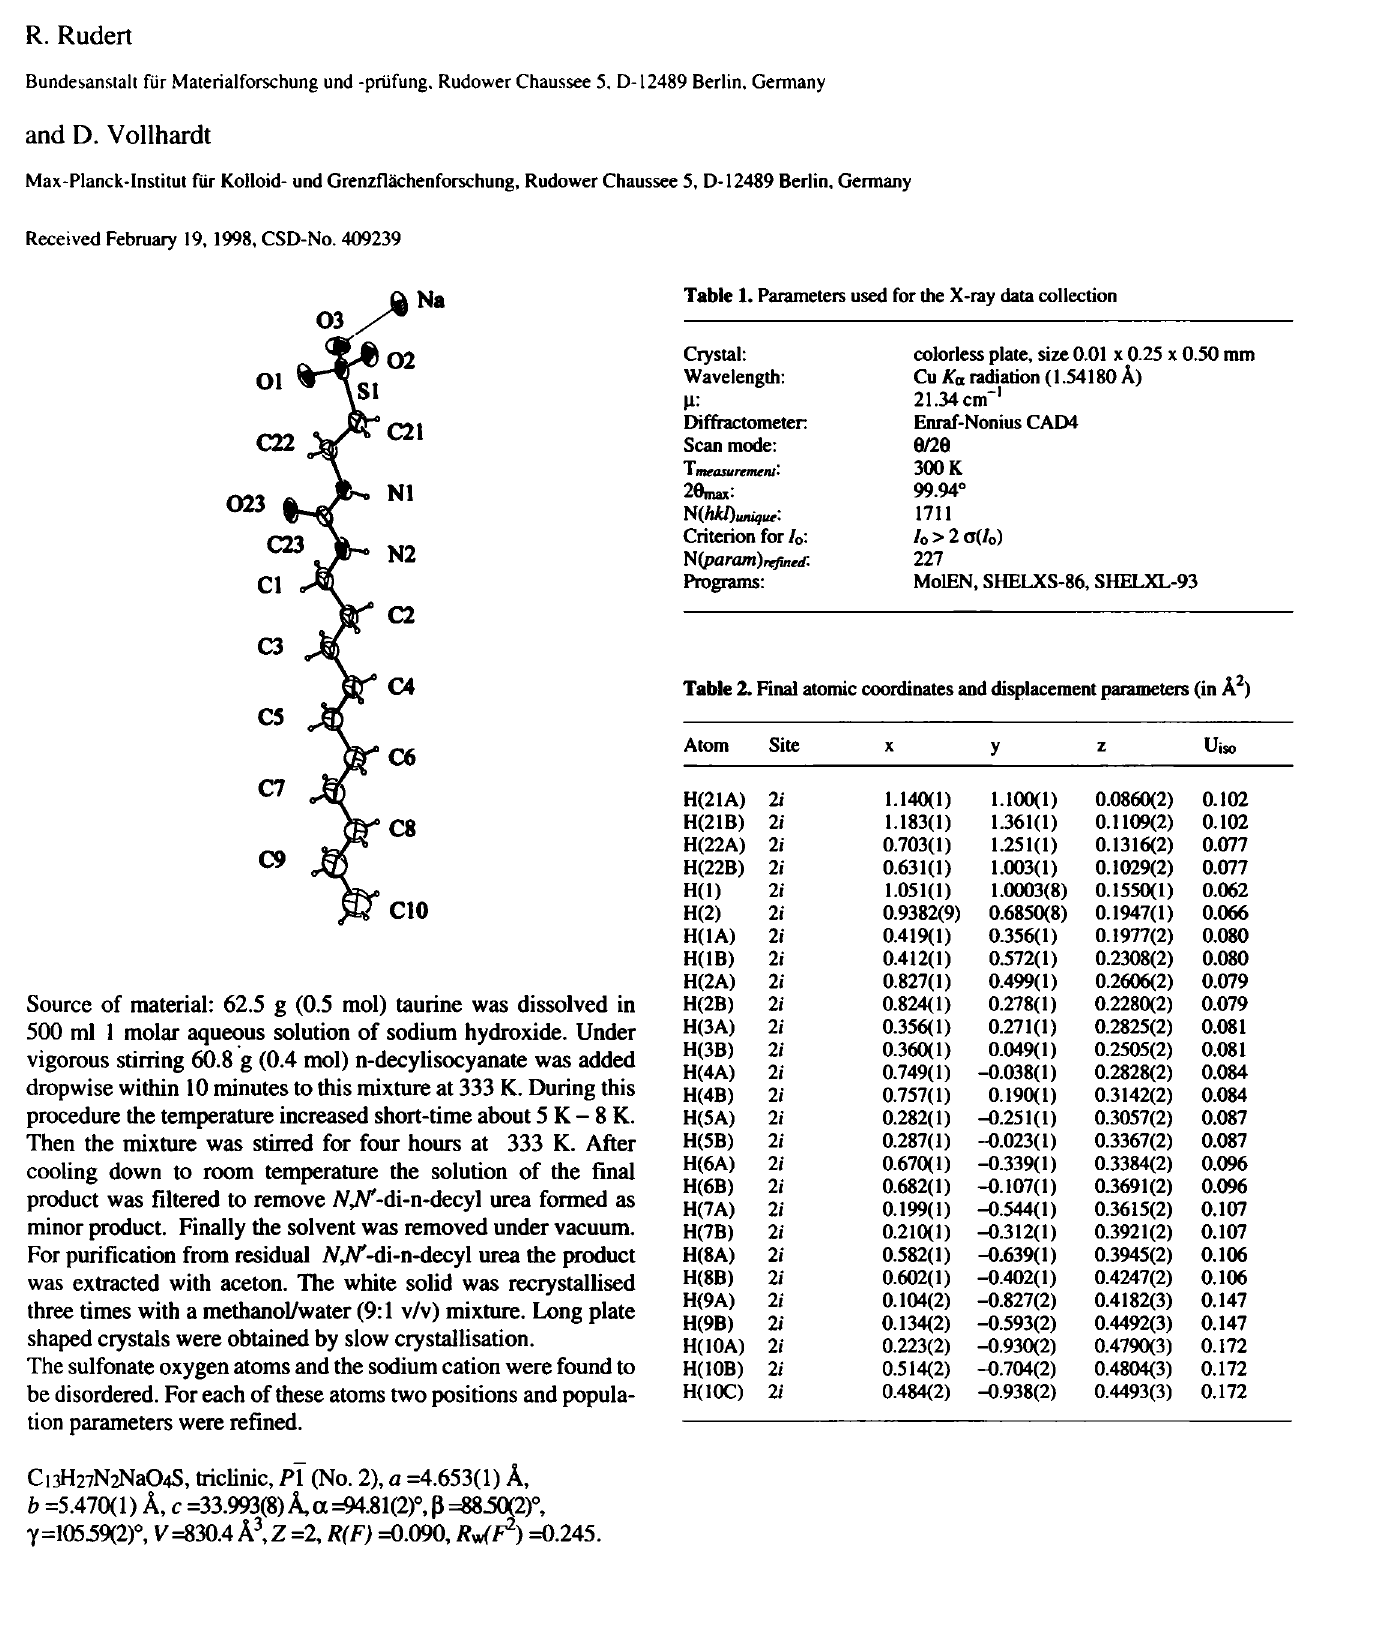
Table 1. Parameters used for the X-ray data collection Crystal: